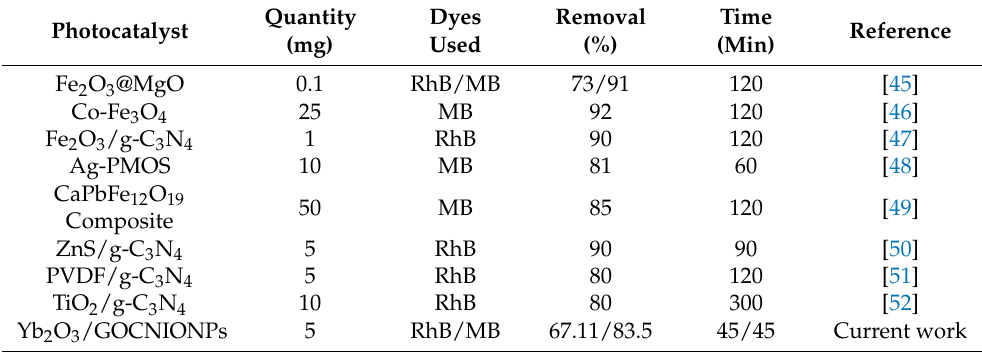
Table 2. Comparative effectiveness of various photocatalysts in the photo-degradation of rhodamine B and methylene